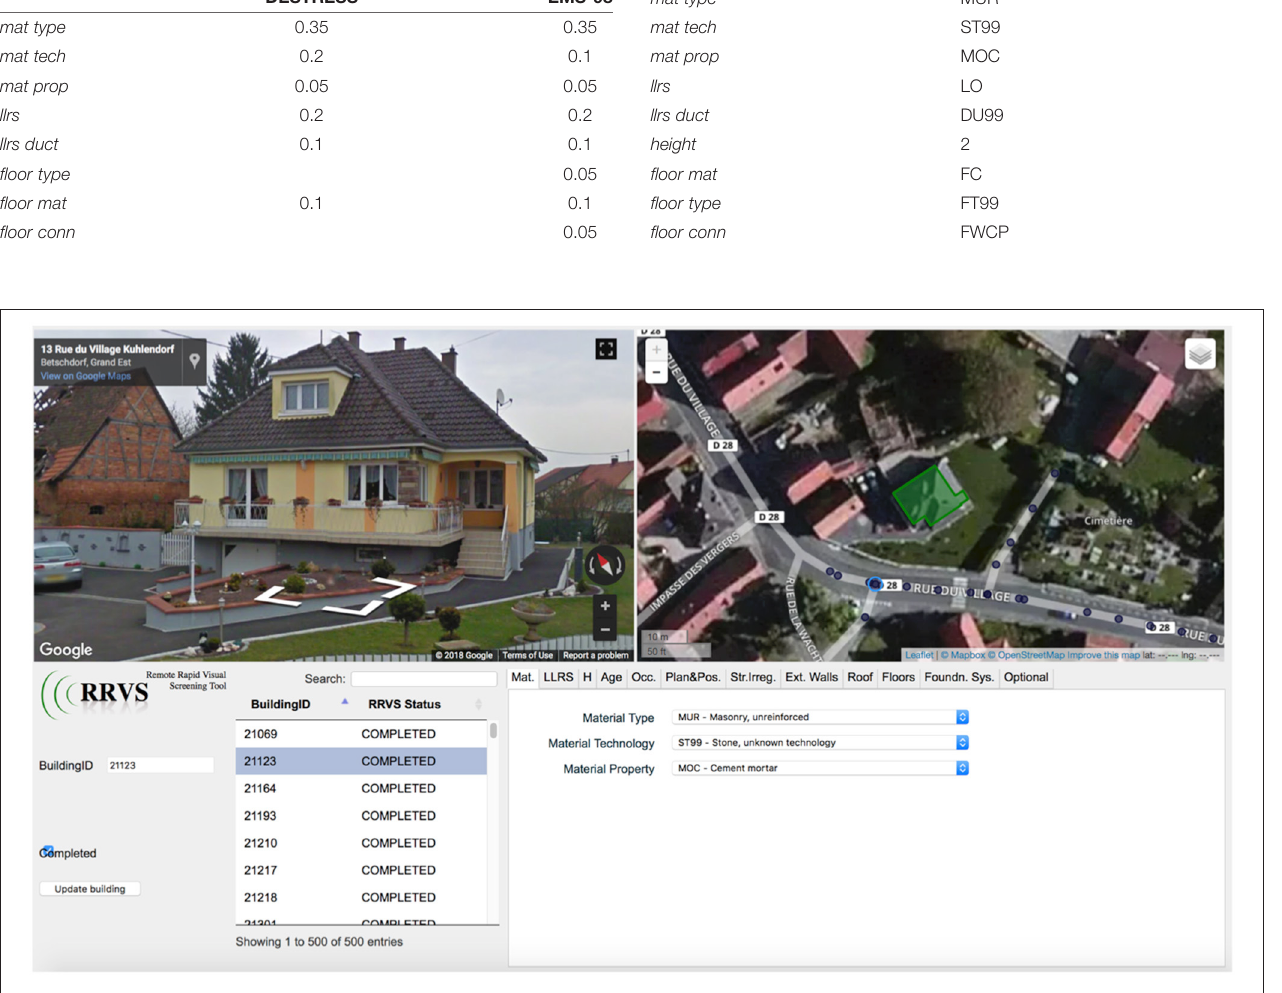
Frontiers in Built Environment |